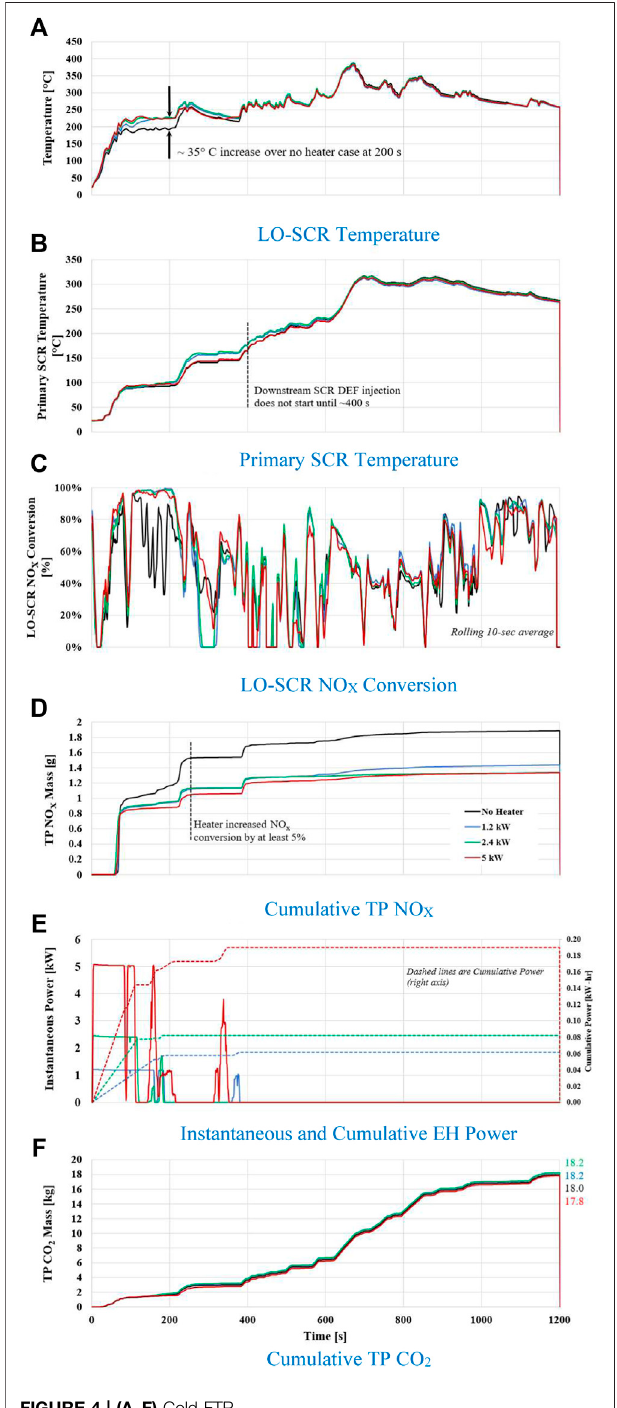
FIGURE 4 | (A – F) Cold